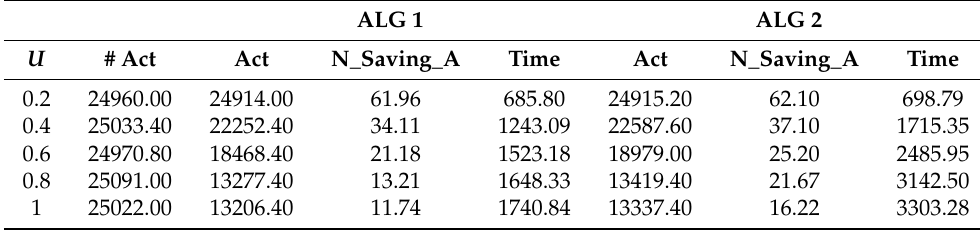
Table 11. 8192 servers-10,000 flows-Activation scheduling with Simple heuristic in phase 2. ALG